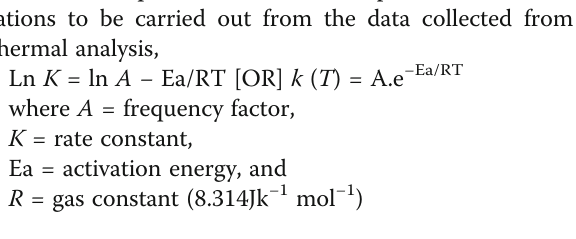
Table 1 Non iso-thermal/dynamic kinetic study and iso-thermal study in thermal analysis [16 – 18] Non iso-thermal/dynamic kinetic